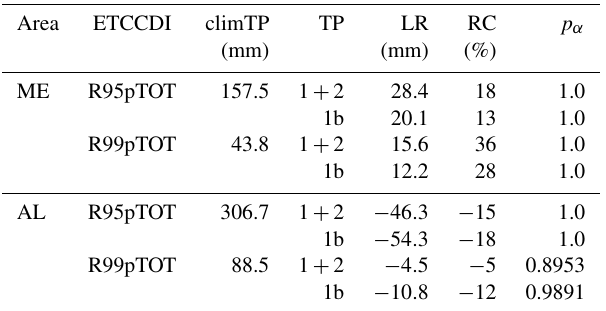
Table 5. Climatological mean (climTP; 1961–1990) of ETCCDI quantities for Mid-Europe (ME) and the Alps (AL), linear regres- sion (LR) and relative change (RC) compared to climTP for differ- ent TPs, and related significance ( p value; α = 0 . 05). Both indices are based on wet days only of daily spatial mean precipitation (land